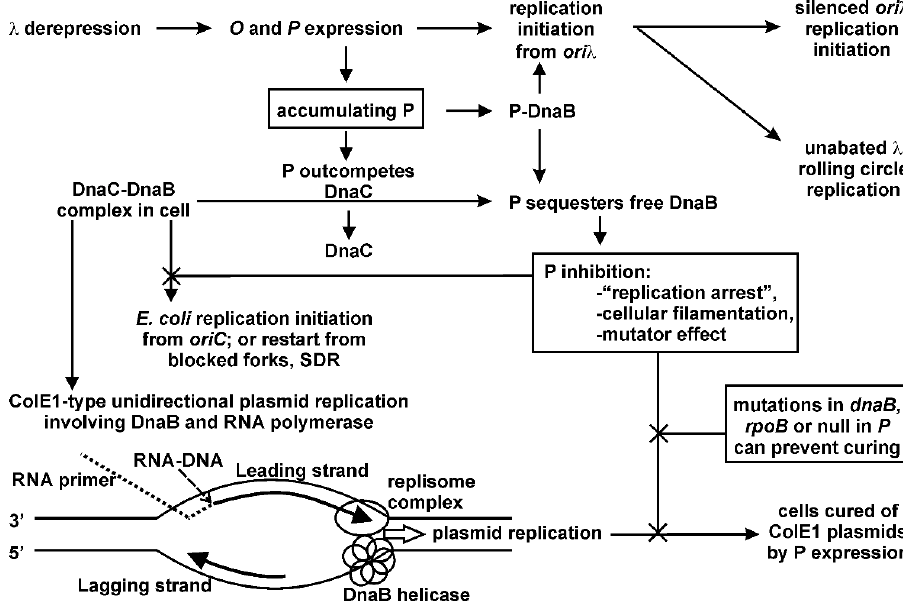
Figure 2. Summary of P lethality/inhibition observations, including observations provided herein. Arrows terminating in X show inhibitory activities. “SDR” is stable DNA replication [44–48]. P can bind DnaB helicase and replace pre ‐ bound DnaC.